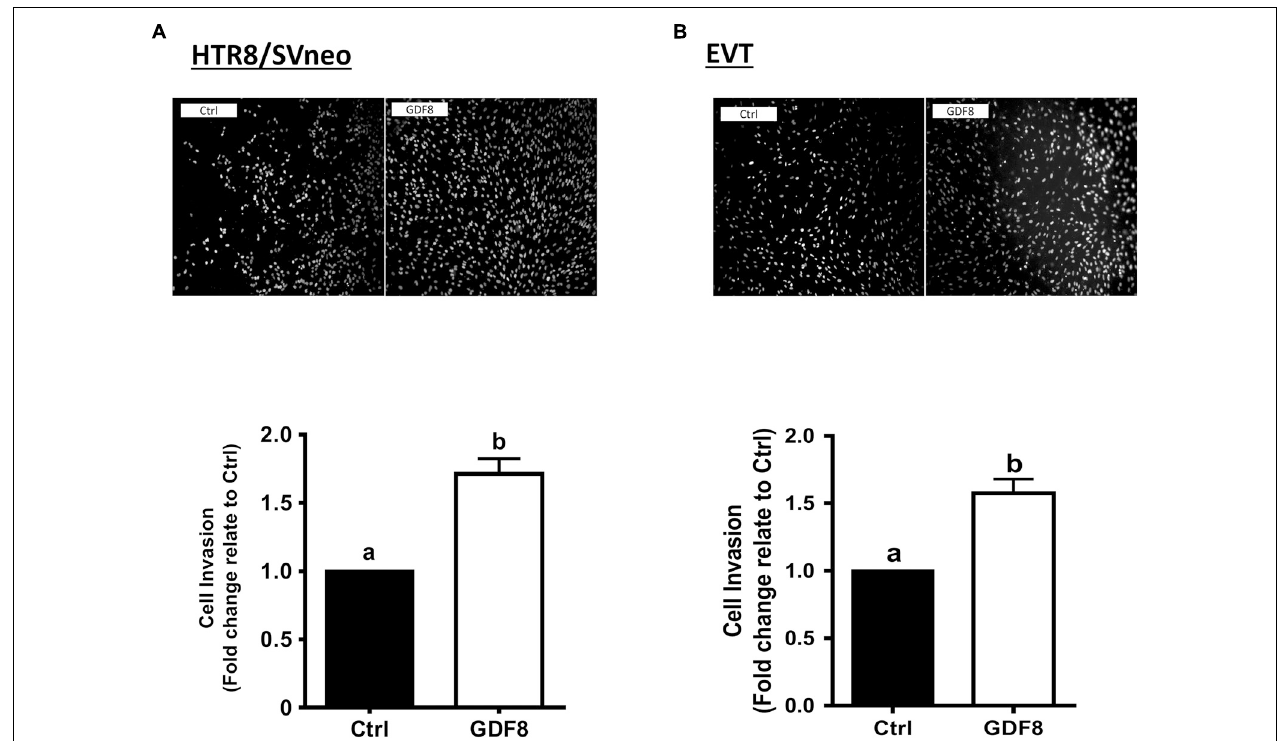
FIGURE 1 | Growth differentiation factor 8 (GDF8) promotes cell invasion in HTR8/SVneo and primary extravillous trophoblast (EVT) cells. HTR8/SVneo (A) or primary EVT (B) cells were treated for 48 h with the vehicle control (Ctrl) or 25 ng/mL GDF8, and cell invasion was examined using the Matrigel-coated transwell assay. The results are displayed as the mean ± SEM of at least three independent experiments, and the values with different letters are significantly different ( P <